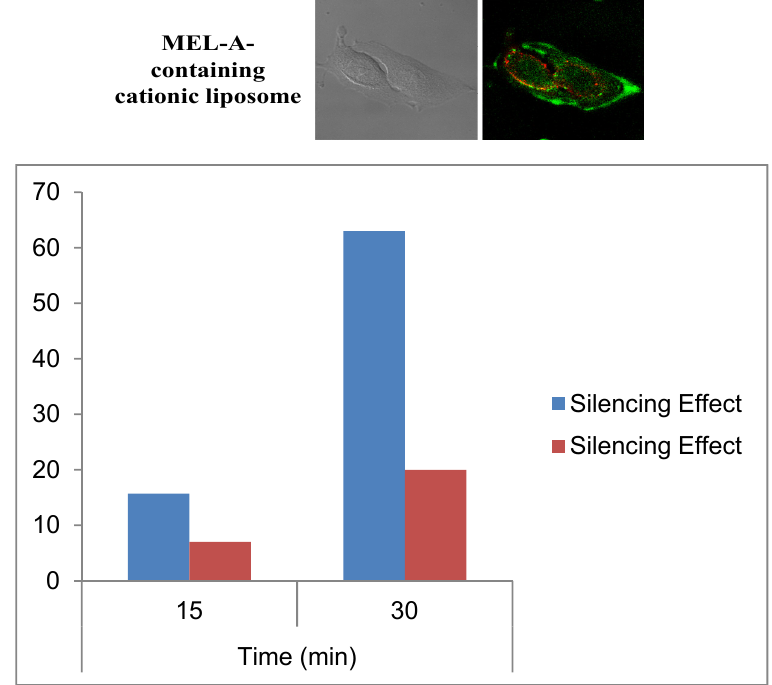
Figure 6. ( Upper ) Intracellular localization of FAM-labeled siRNA with MEL-A-containing cationic liposomes. Lysotracker Red stained B16/BL6 cells were observed 0.5 h after incubation with liposome/siRNA. Left is DIC and Right is a CLSM image of FAM-labeled siRNA; ( Lower ) Time-depended silence effects for the experiments with MEL-A-containing cationic liposomes (blue) and Lipofectamine™ RNAiMax